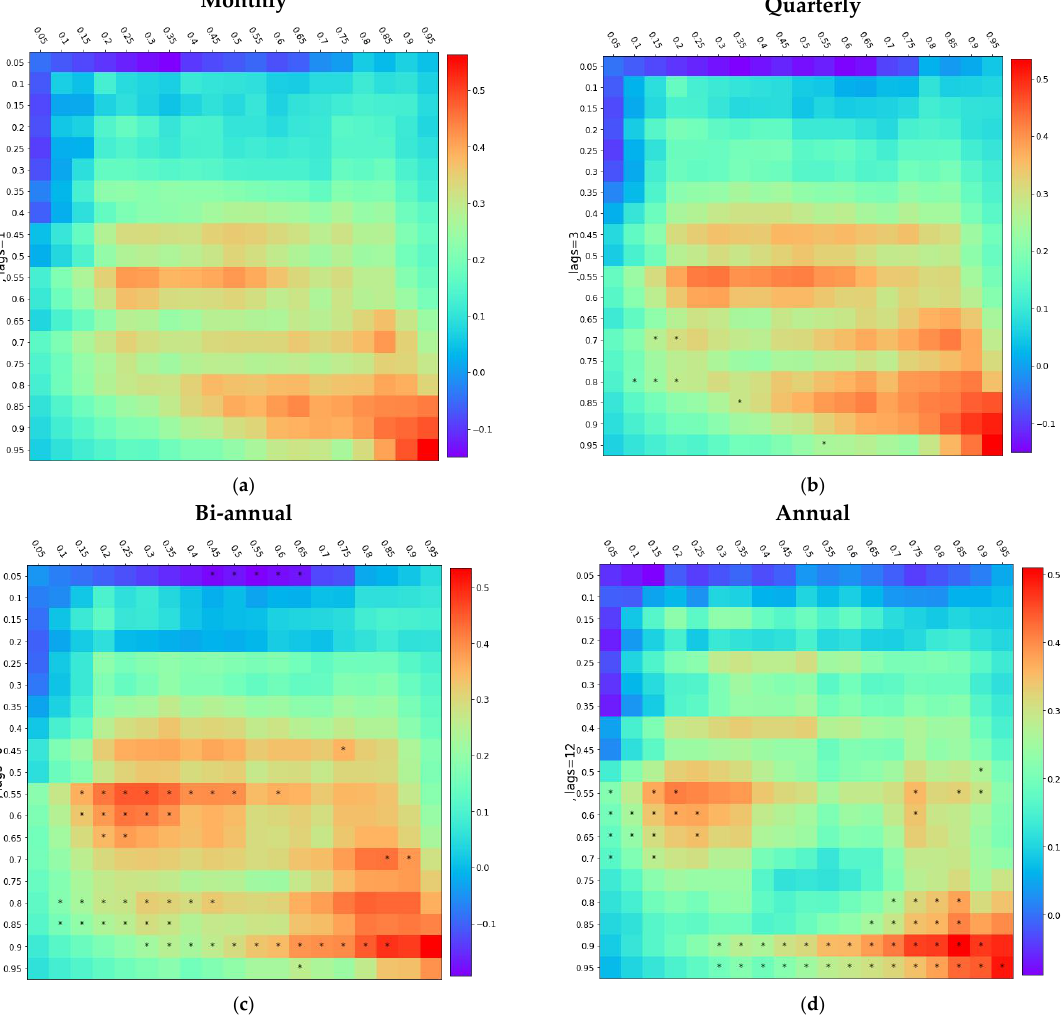
Figure 4. Effect of USA’s economic policy uncertainty ( UEPU ) on mineral import ( MI ) in short (monthly ( a ) and quarterly ( b )), medium (bi-annual) ( c ) and long (annual) ( d ) memories. Notes: * shows the significance level. 0.95 depicts the highest bullish scenario, and 0.05 shows the lowest bearish state for both the UEPU and MI demand. The deep blue spectrum exhibits a solid negative consequence, while the deep red range portrays the strong positive influence of the UEPU on MI . Besides, light green and red colors display a moderately positive relationship between UEPU and MI .